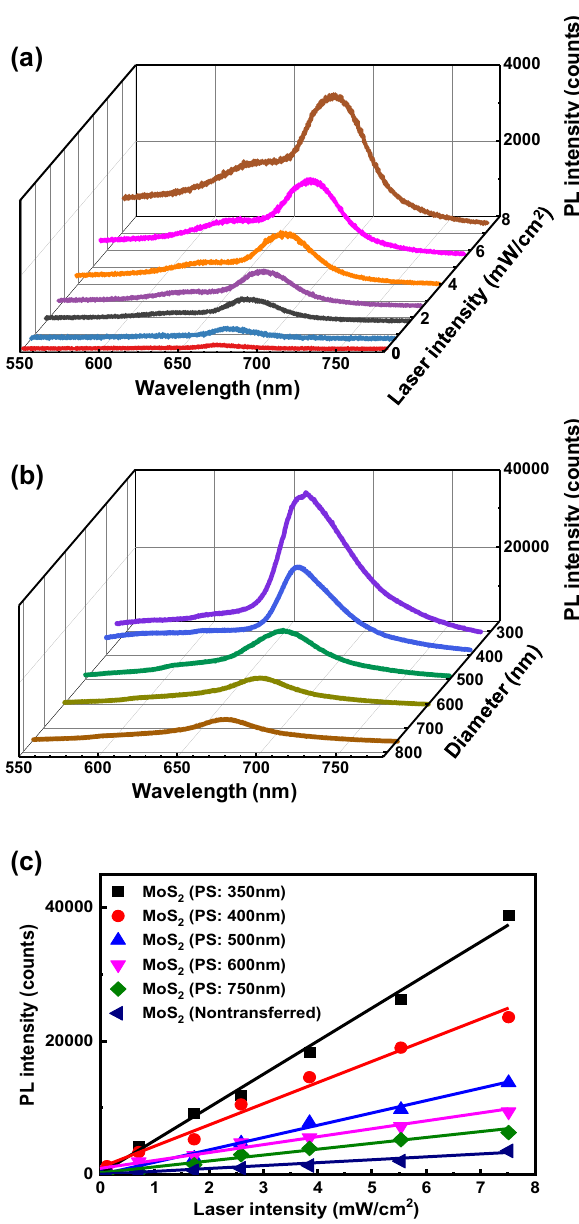
Figure 3: The measured PL signals of (a) the nontransferred 1-L MoS2 as a function of the pumping laser intensity (0.8 – 7.8 mW/ cm 2 ), and (b) the transferred 1-L MoS2 on different Au metasurfaces made by the nanospheres with different sizes in diameter (350 – 750 nm) under the fi xed pumping laser intensity of 7.8 mW/cm 2 . (c) The scatter plot for the PL intensity of A-exciton in 1-L MoS2, including samples nontransferred and samples transferred onto various metasurface. The straight line in the fi gure is the result of linearly fi tting for the spots in the scatter plot. The color of the line corresponds to the color of the fi tted